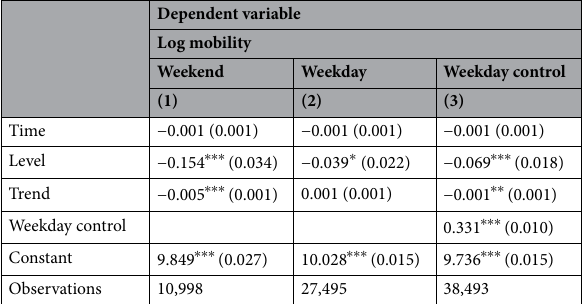
Table 4. OLS regression results: the Weekend regression is only run on the data points on the weekend whereas the Weekday regression is only run on the data points on the weekdays. We introduce a weekday control, measuring both the weekends and weekdays mobility. ∗ p<0.1; ∗∗ p<0.05; ∗∗∗